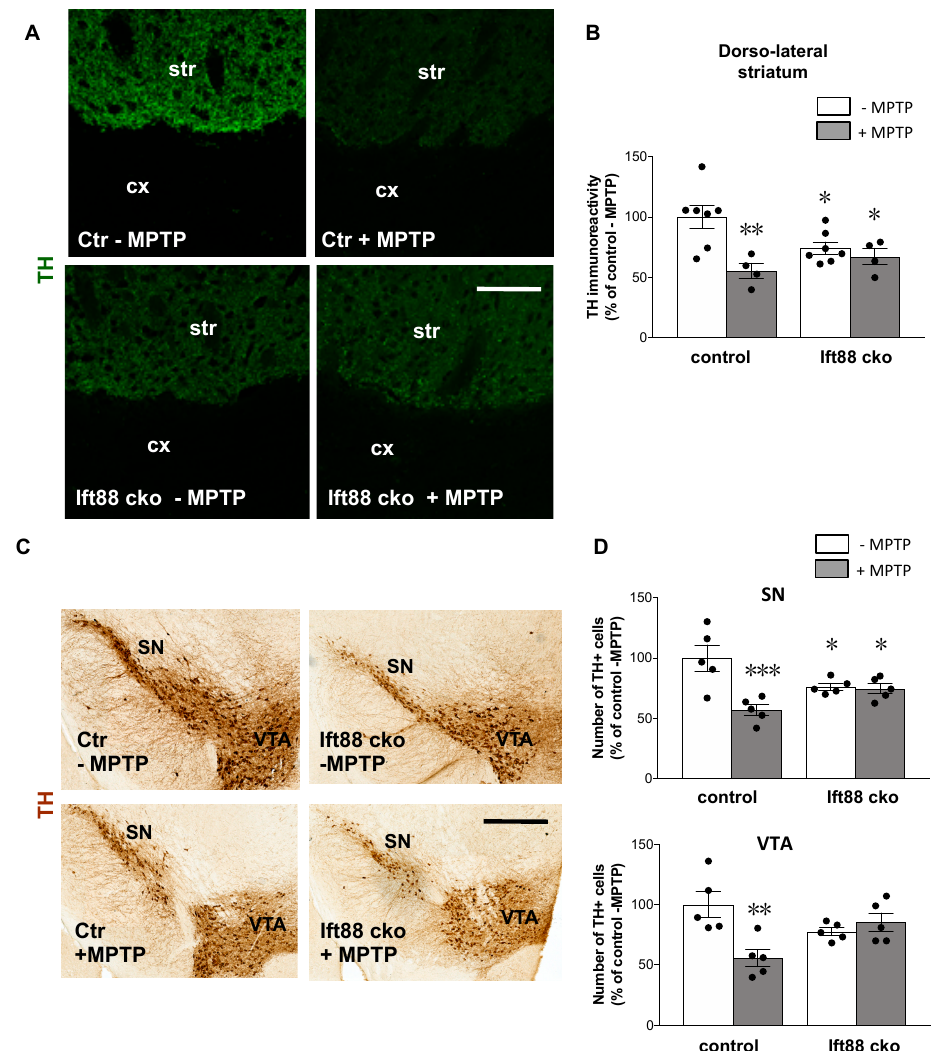
Figure 4. Loss of primary cilia in DA neurons results in decreased neurotoxic response to MPTP treatment. ( A ) Representative confocal images of TH immunoreactivity (green) in the dorsal striatum of control and Ift88 cKO mice with and without MPTP treatment at 6 months. ( B ) Semi-quantitative analysis of TH fluorescence mean intensities in the dorsal striatum of vehicle ‐ treated control and Ift88 cKO mice ( n = 7 per group) and of MPTP ‐ treated control and Ift88 cKO mice ( n = 4 per group). ( C,D ) Stereological analysis of the number of DA neurons in the SN and VTA of control and Ift88 cKO mice treated and not treated with MPTP ( n = 5 per group). The data are presented as the mean ± SEM. Statistical significance between the indicated groups determined by two ‐ way ANOVA followed by Fisher’s LSD test * p < 0.05, ** p < 0.005, *** p < 0.0005 (for details, see also supplementary statistical information). Abbreviations: Ctr, control; str, striatum; cx, cortex. Scale bar, 100 μ m ( A ), 500 μ m.